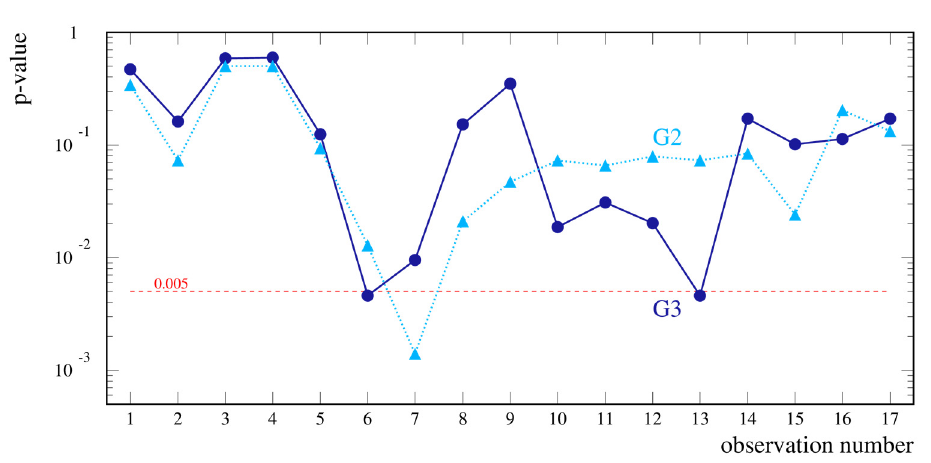
Figure 8. The time evolution of the p-value of the 2a hypothesis for groups G2 and G3. Lines are only to guide eye.